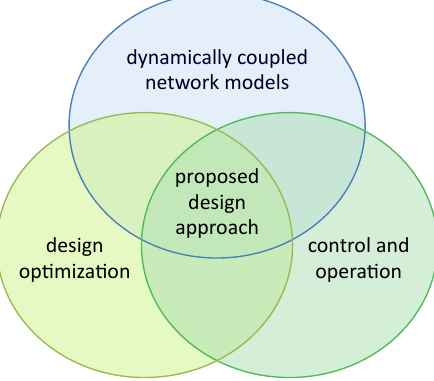
Figure 1. Scope of the design approach proposed in this